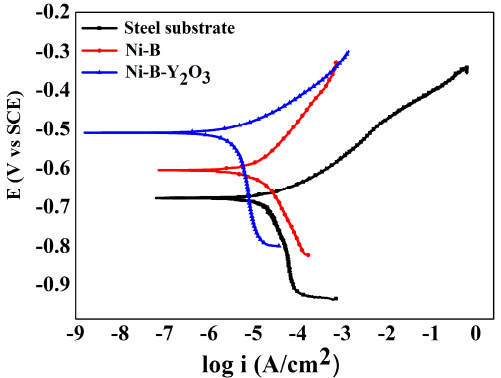
Figure 7. Potentiodynamic polarization of Ni ‐ B ‐ Y 2 O 3 composite coatings in 3.5 wt % NaCl aqueous solution at the scan rate of 0.167 mV ∙ s − 1 .